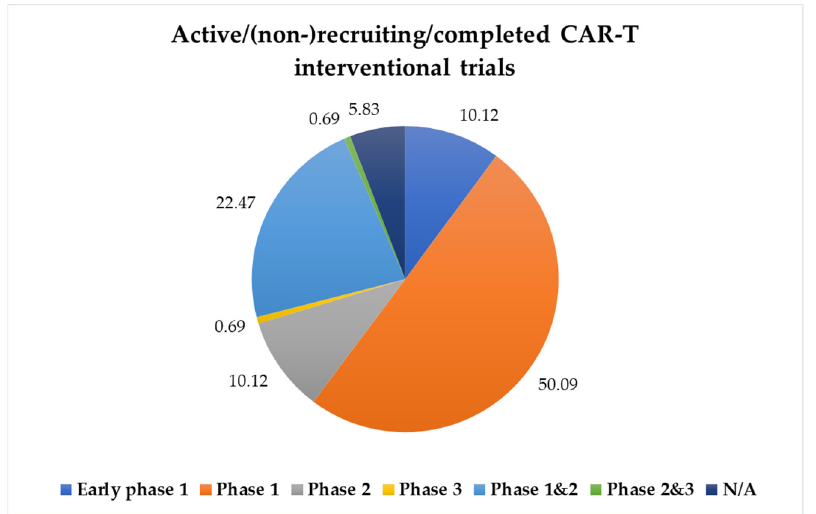
Figure 2. Study phase of CAR-T interventional trials. The percentage of CAR-T interventional trials that have been completed or are currently recruiting in each of the study phases. Data obtained from https://clinicaltrials.gov/; search for CAR cells; accessed on 4 January 2023. CAR-T, chimeric antigen receptor T